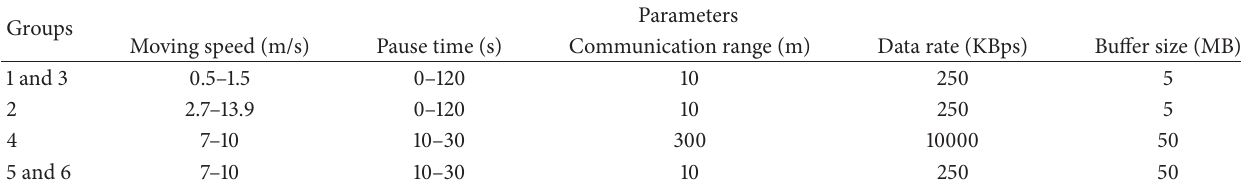
Table 1: Parameters for nodes in different groups.